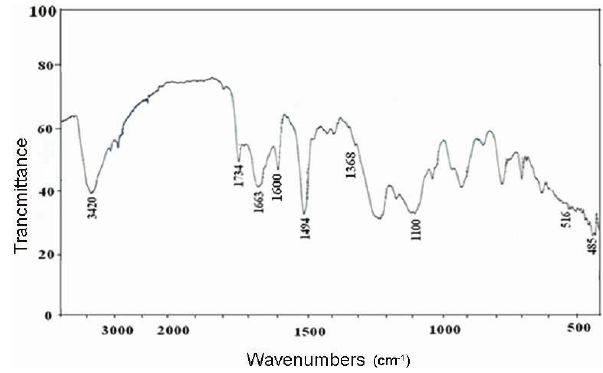
Figure 1. FTIR spectrum of PA-nanocomposite films 3a